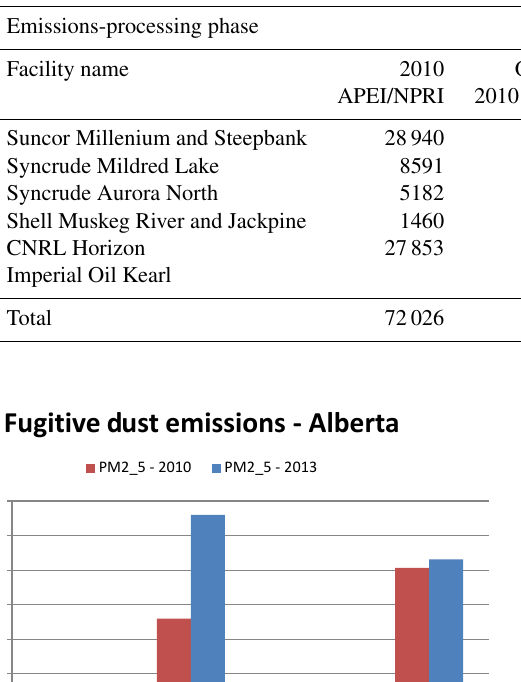
Table 1. Comparison of annual facility-total VOC emissions (tonnes) between 2010 NPRI, 2010 CEMA, and versions 1 and 2 of the 2013 NPRI for the OS mining facilities within the AOSR study area.